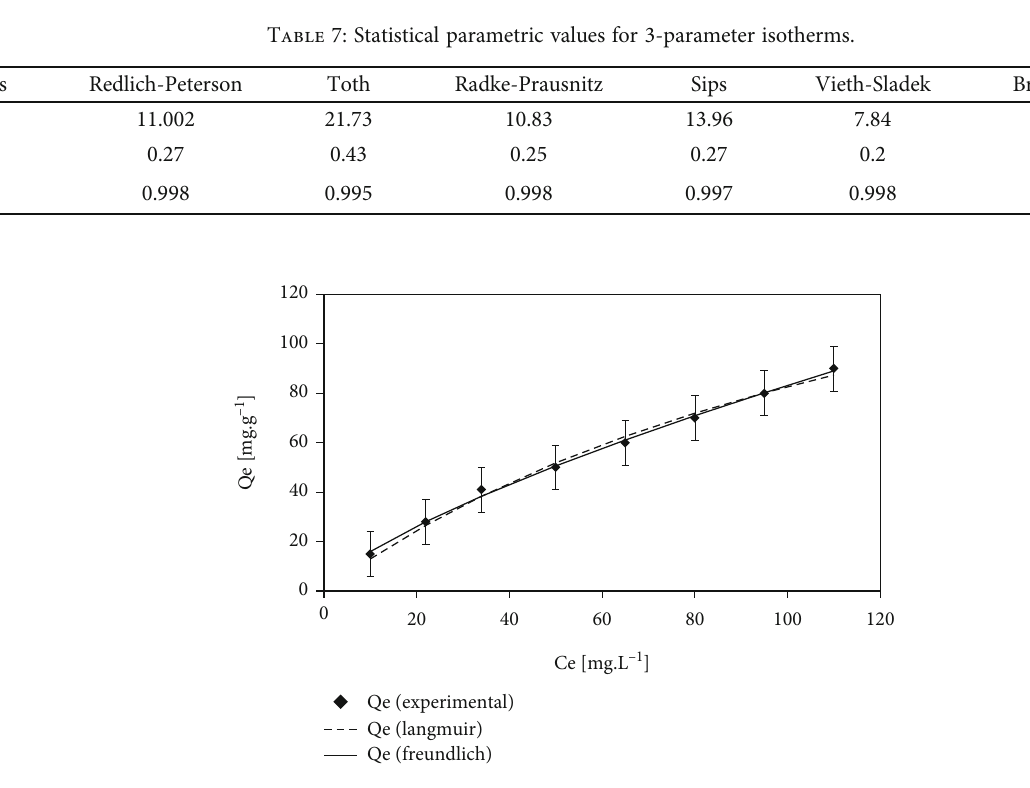
Figure 10: Adsorption data to Langmuir isotherm and Freundlich